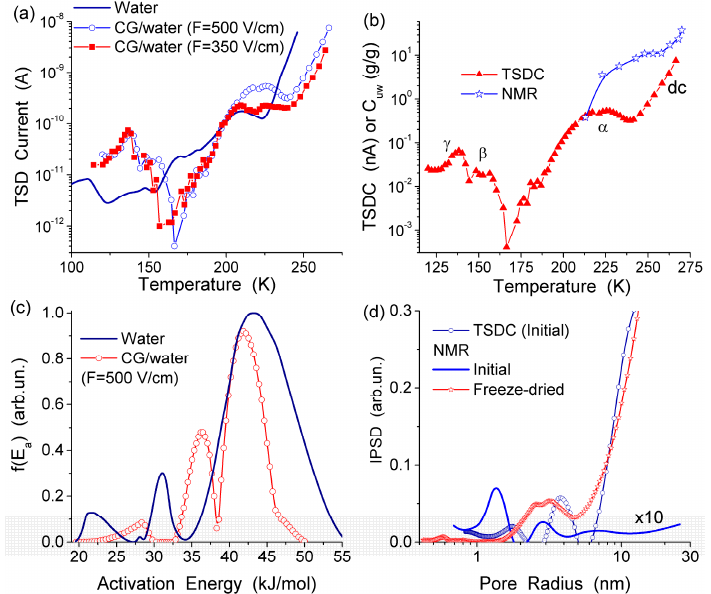
Figure 11. ( a ) Temperature dependence of the TSD current for the initial collagen hydrogel and “free” (bulk) water; ( b ) temperature dependences of the TSD current and the amounts of unfrozen water ( C uw ) (NMR) for initial collagen HG (98.5 wt % of water) ( c ) distribution function of the activation energy of relaxation in these systems; and ( d ) incremental pore size distributions for the initial CG HG calculated on the basis of 1 H NMR and TSDC data (adapted from [76] with permission, Copyright 2006,